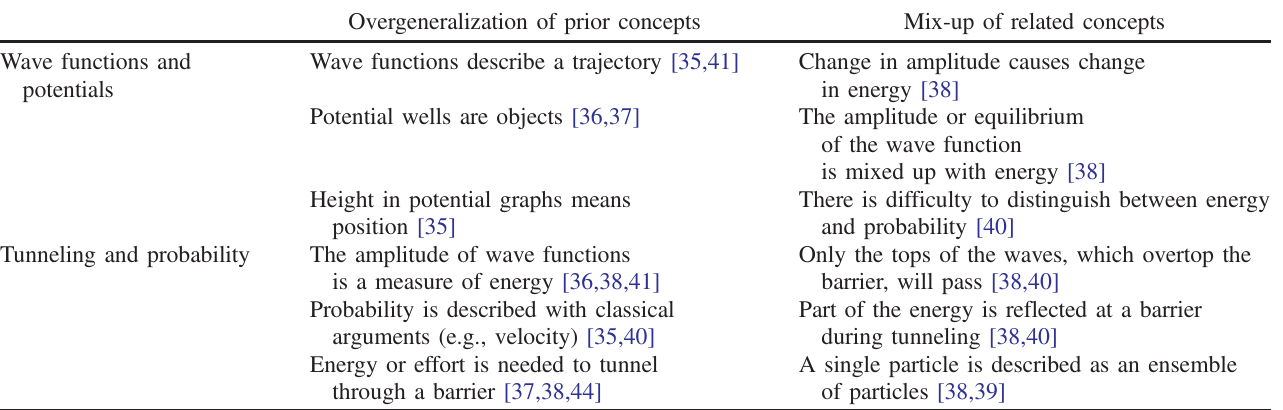
TABLE III. Misconceptions about wave functions and potentials, categorized into two categories.